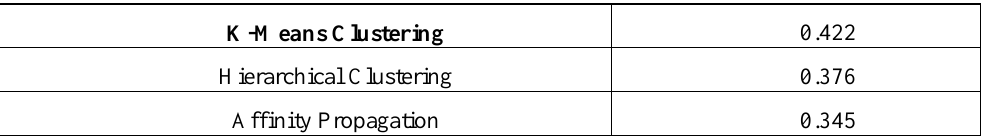
Table 2. Cluster